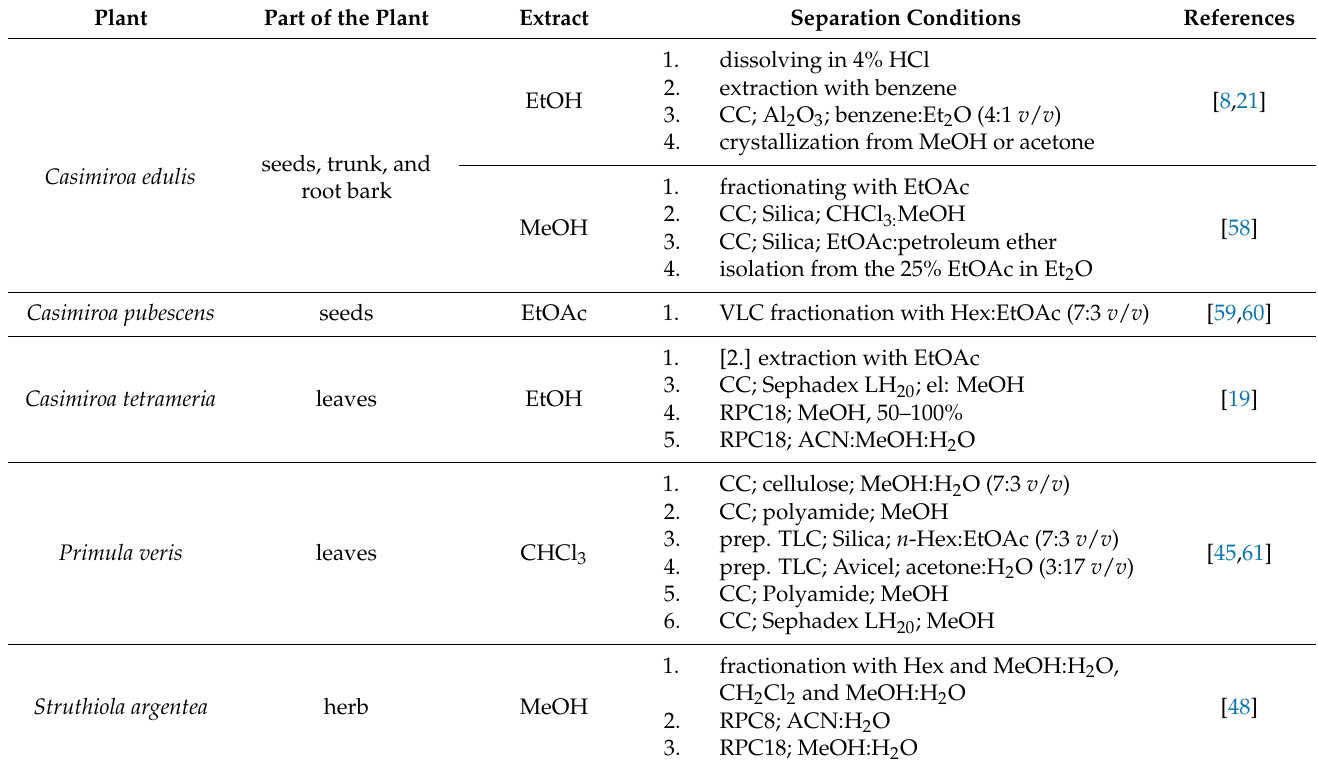
Table 2. Column chromatography in the separation of zapotin.